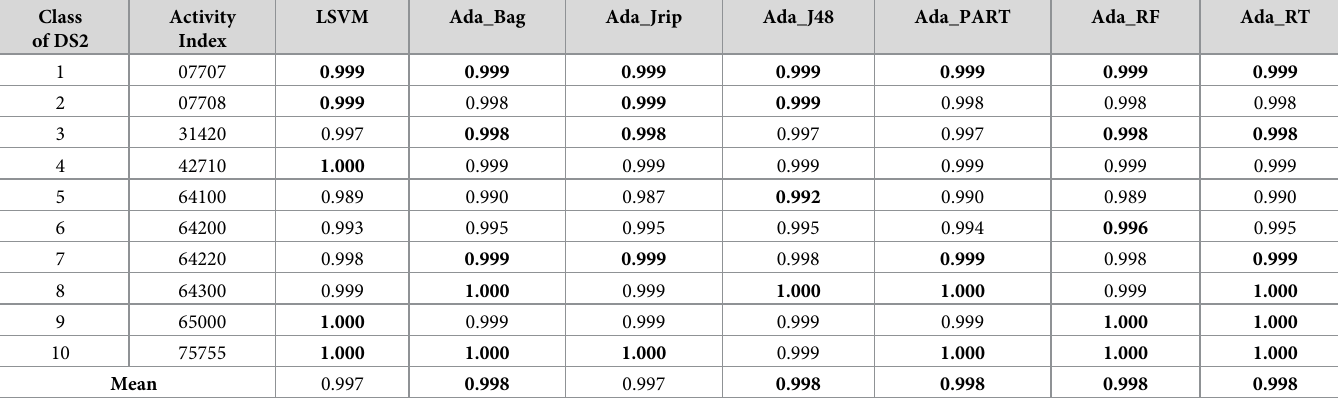
Table 8. Specificity measure for the prediction of new bioactive molecules with DS2 (homogeneous).